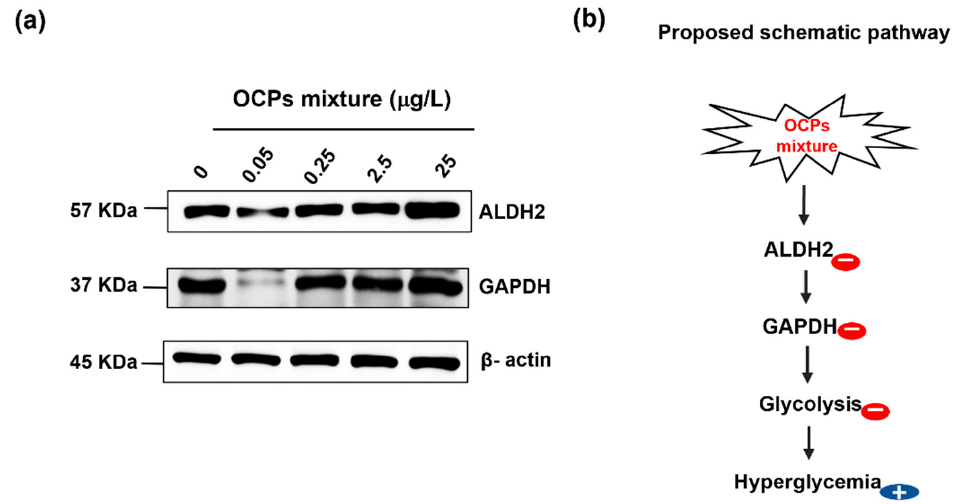
Figure 4. Validation of aldehyde dehydrogenase (ALDH2) and glyceraldehyde 3-phosphate de- hydrogenase (GAPDH) expression and proposed mechanism of OCPs-induced hyperglycemia in zebrafish: ( a ) Western blot analyses of ALDH2 and GAPDH expression at different concentrations of organochlorine pesticide mixtures; ( b ) A proposed pathway underlying hyperglycemia -related effects induced in zebrafish.